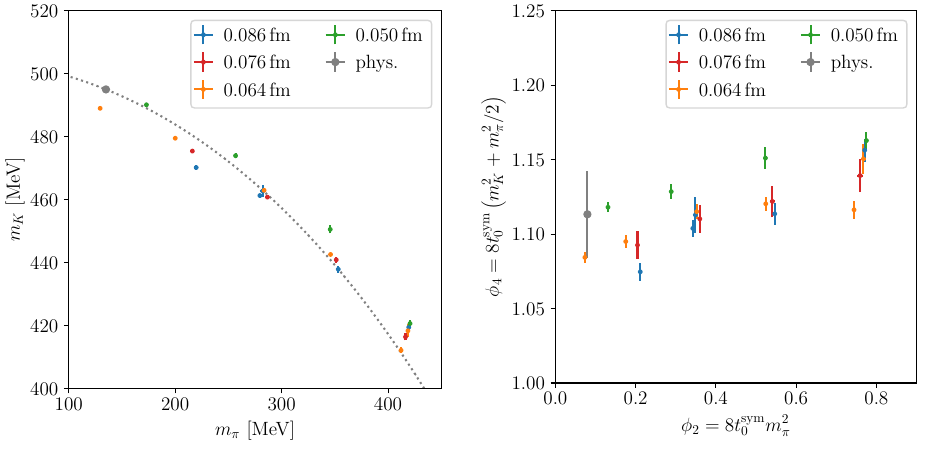
Figure 2 . Landscape of the ensembles from the CLS initiative employed in this